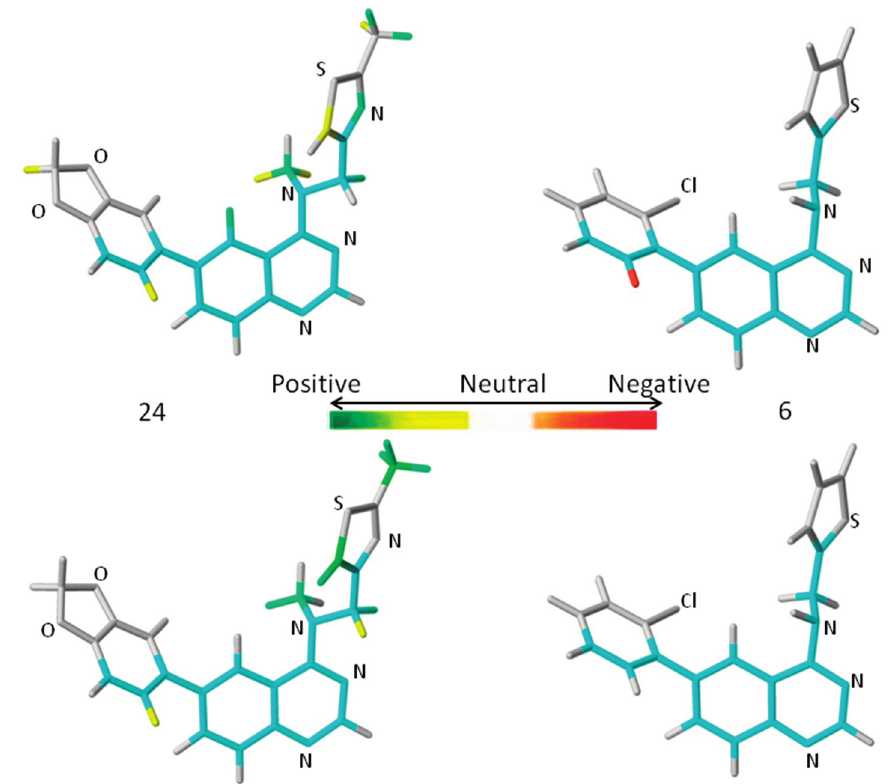
Figure 3. The HQSAR contribution maps of the most ( 24 , left ) and least ( 6 , right ) active compounds, according to the two best HQSAR models A/B/C/Ch/DA ( top ) and A/B ( bottom ). Color code: yellow-to-green, white, and orange-to-red represent positive, neutral, and negative contributions to the biological activity, respectively, and cyan represents the common backbone. The Cl, N, O, and S heteroatoms are labeled by element symbol, C and H atoms are not